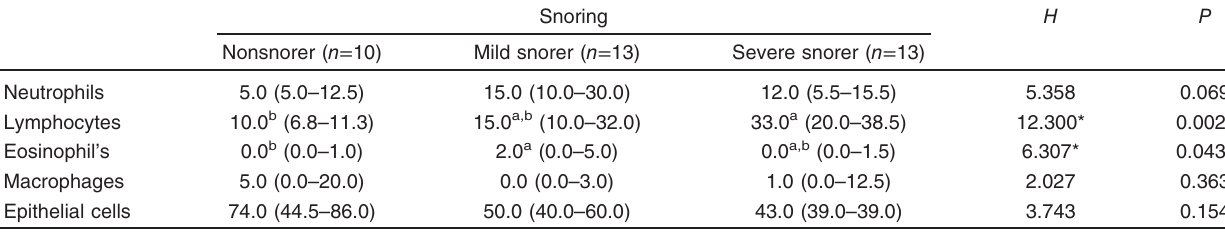
Abnormally distributed data were expressed in median (interquartile range). Means with common letters are not significant (i.e. means with different letters are significant). H : H for Kruskal – Wallis test, pairwise comparison between each two groups was done using post-hoc test (Dunn ’ s for multiple comparisons test). P : P value for comparing between the studied groups. * P ≤ 0.05,